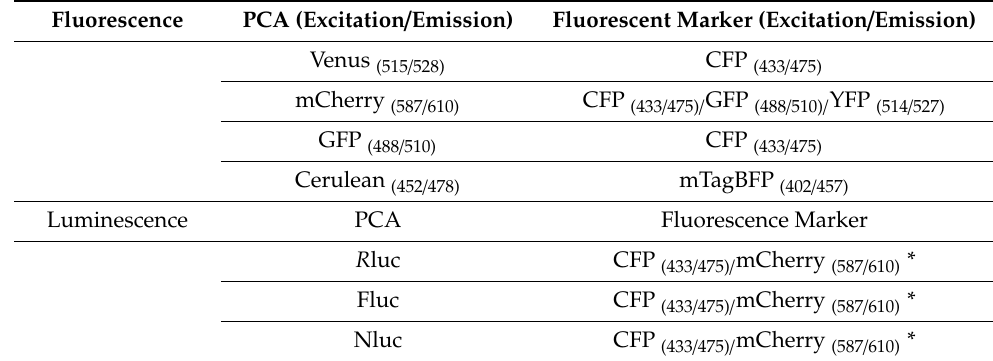
Table 7. The application of normalization factors. * Given as